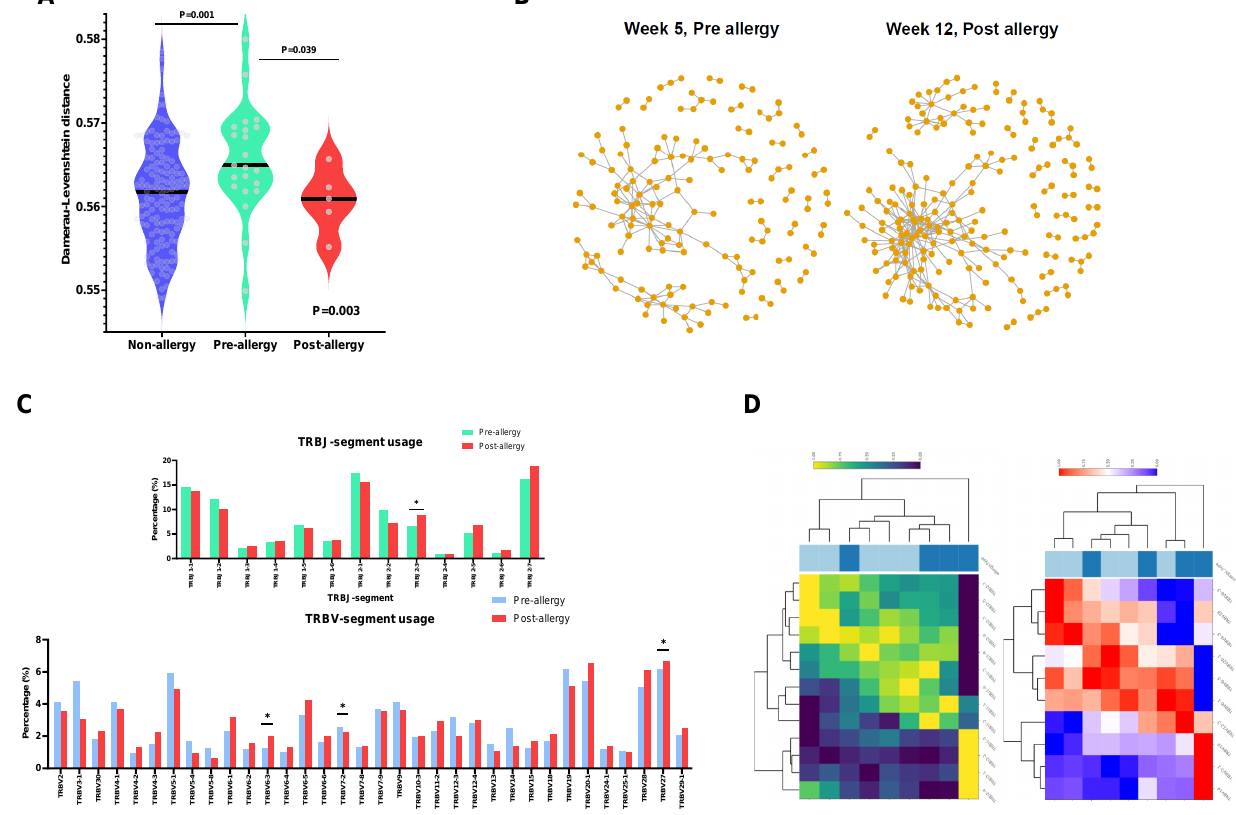
region 3 (CDR3) sequences and their proportions (Supplementary Figure S6B), with only one common sequence noted from the same patient. Taken together, these findings point to a convergent TCR response to a common antigen, as well as to antigen-driven shaping of the TCR repertoire after the occurrence of allergy.